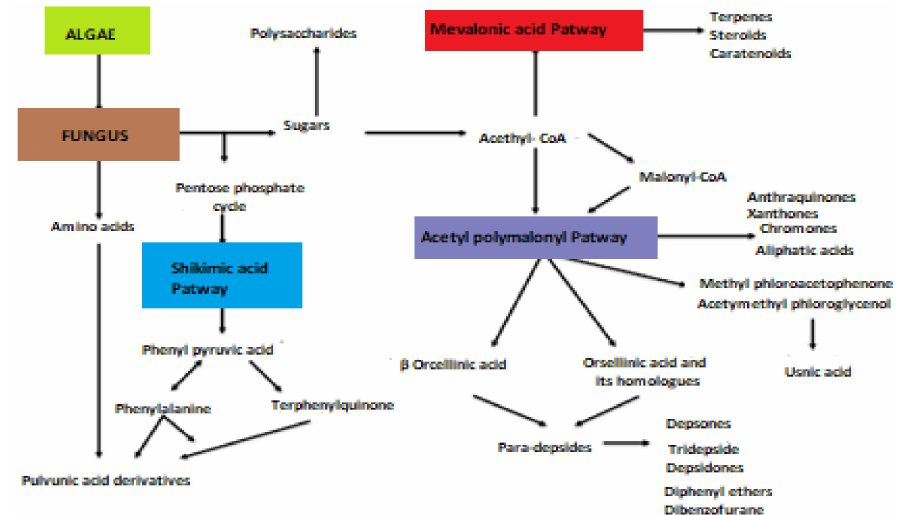
Figure 1. Biosynthetic pathways of lichen secondary metabolites (Elix, 1996; Stocker wörgötter,